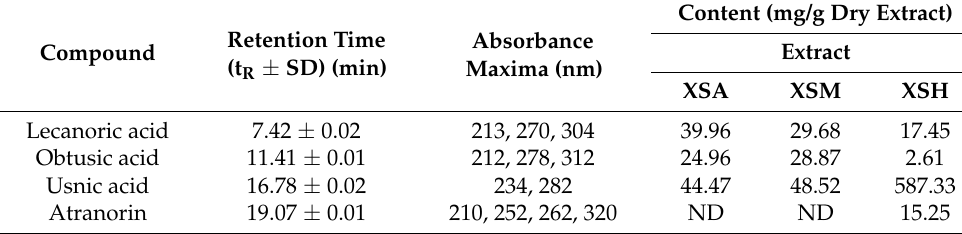
Table 2. Retention time, absorbance maxima, and content of the identified lichen substances.